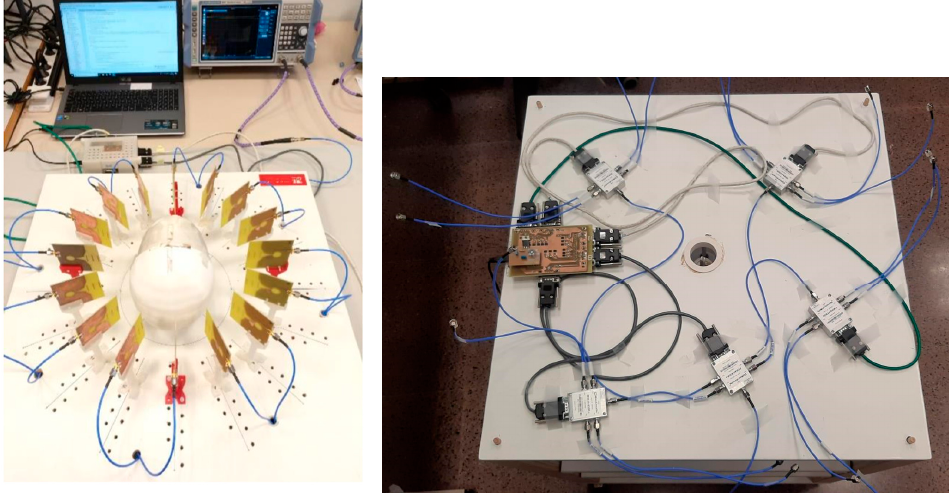
Figure 1. Microwave image system ( left ) and control and switching subsystem ( right ). The wideband antennas constitute one of the key parts of the measurement system.